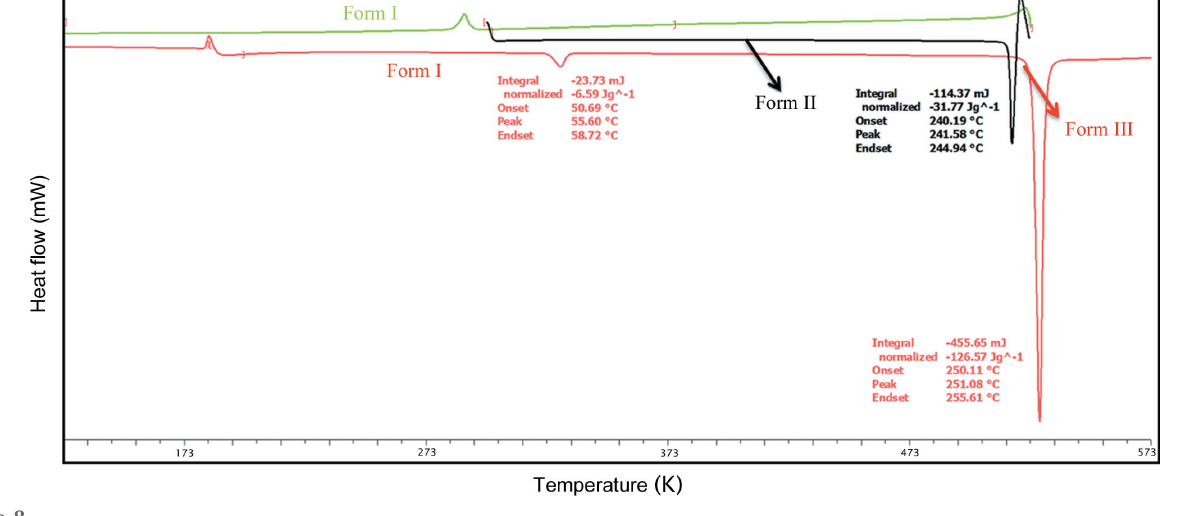
Figure 8 DSC thermogram of Compound-A Form II (heat–cool–reheat).